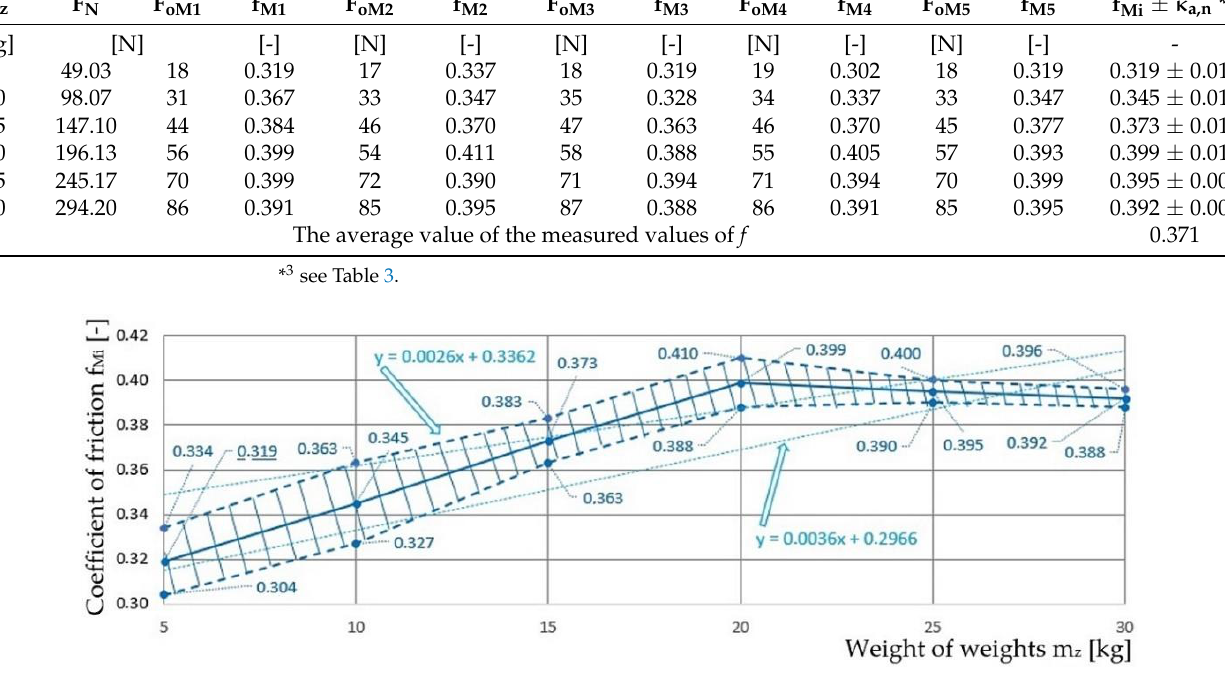
Figure 5. Values of the friction coefficient obtained in the laboratory, 10 mm diameter cable, dry and clean groove surface.